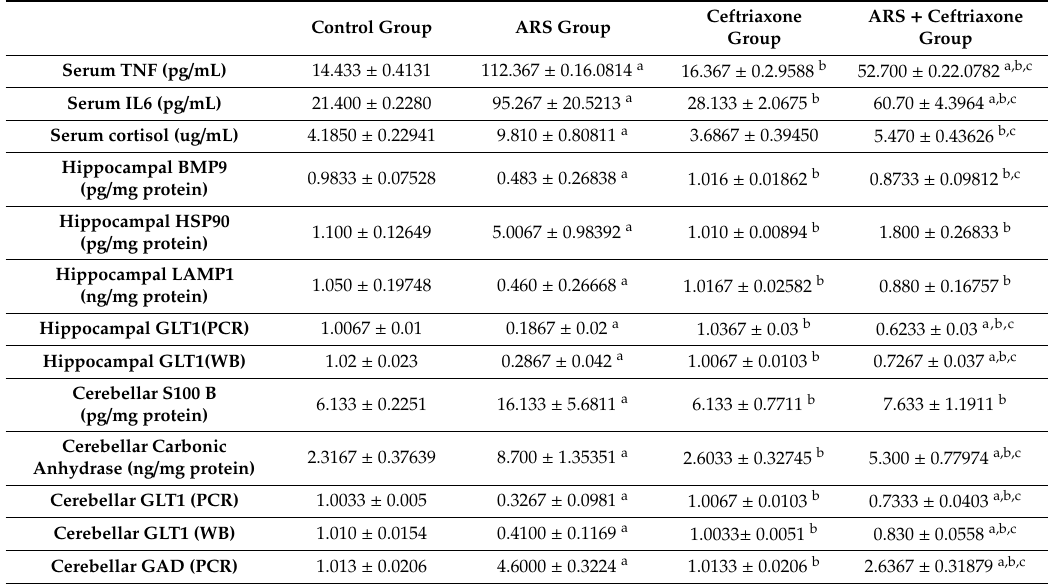
Table 3. Biochemical analyses of serum hippocampal and cerebellar tissues in the studied groups.